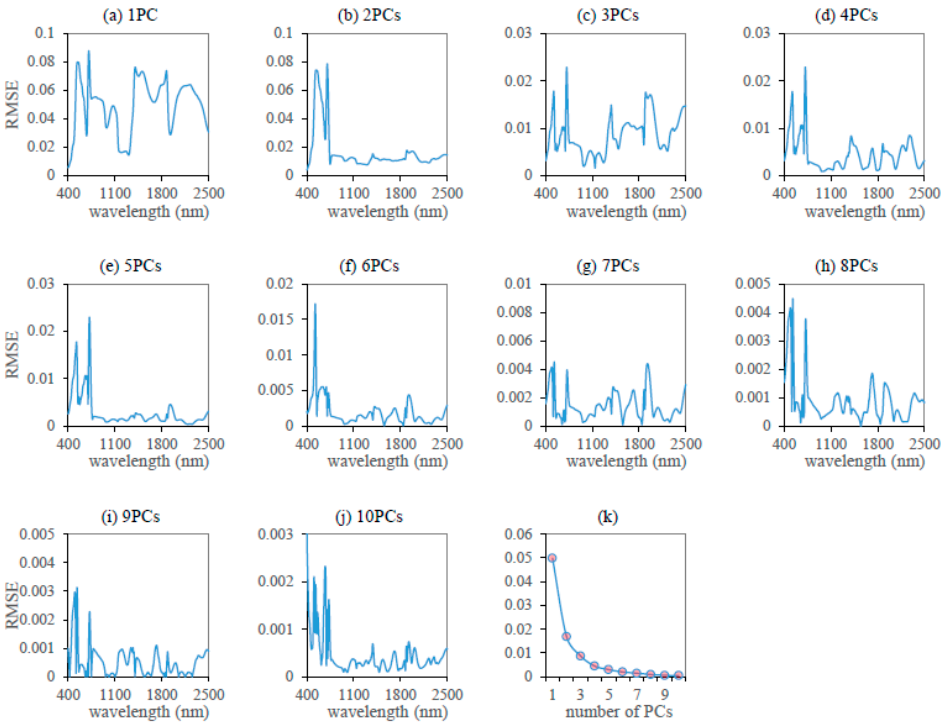
Figure 4. ( a – j ) Spectral root mean squared error (RMSE) between simulated leaf reflectance and reconstructed reflectance using the PCA method with different principal components (1-10PCs); ( k ) values of different principal components